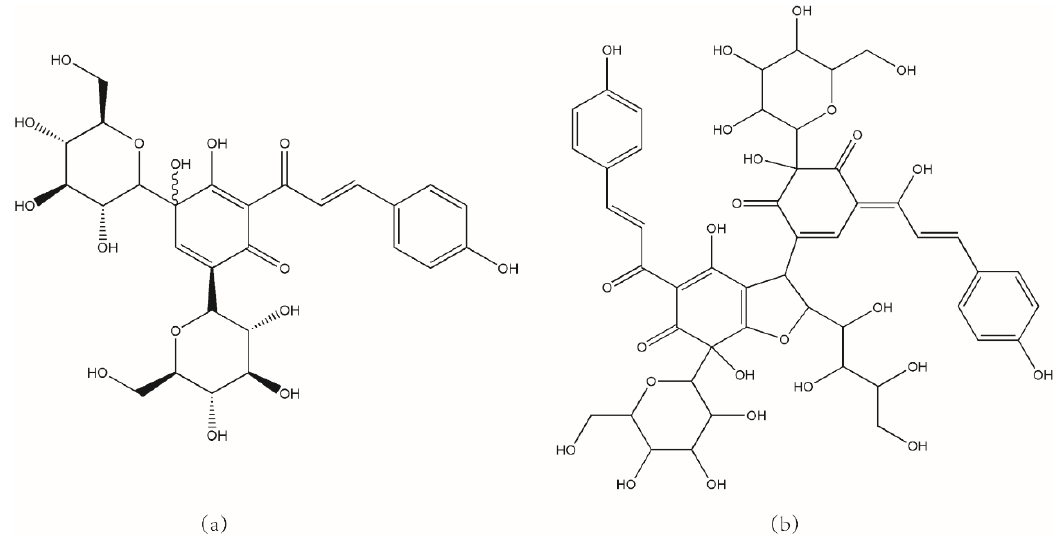
Figure 1. The structures of hydroxysafflor yellow A (HSYA) and anhydrosafflor yellow B (AHSYB): ( a ) HSYA and ( b ) AHSYB.